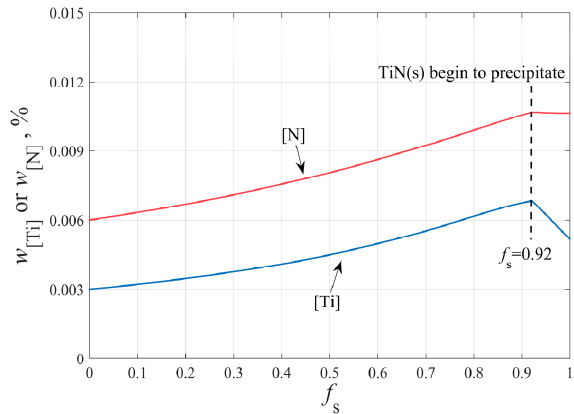
Figure 6. The contents of Ti and N in molten steel during solidification.